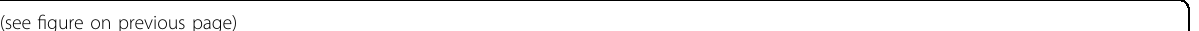
Fig. 4 NDUFA4L2 is not regulated by HIF-1 α in GBM and Apatinib effectively inhibits NDUFA4L2 expression and induces autophagy in GBM cells. A Immunoblot analysis of HIF-1 α and NDUFA4L2 protein levels in T98G, LN229, and GBM-XX cells cultured under normoxic or hypoxic conditions (1% O 2 for cell cultures). B Immunoblot analysis of HIF-1 α and NDUFA4L2 protein levels in LN229 cells cultured under normoxia or hypoxia for 24, 48, and 72 h. C Based on TCGA data, the correlation between the expression levels of HIF-1 α and NDUFA4L2 in patients with glioma was analyzed using the Pearson method. D Protein levels of HIF-1 α and NDUFA4L2 in T98G and GBM-XX cells cultured under normoxia with digoxin (100nM) or 2-ME (10 μ M) were determined by western blotting. E Protein levels of HIF-1 α and NDUFA4L2 in T98G and GBM-XX cells cultured under hypoxia (24 h) with digoxin or 2-ME were determined by western blotting. The images shown are representative of three experiments. F Immunoblot analysis of NDUFA4L2, LC3, p62, Beclin-1, and ATG7 protein levels in T98G, LN229, U373, and GBM-XX cells following treatment with apatinib (0, 5, 10, 20, and 40 μ M). G , H Apatinib-treated LN229 and GBM-XX cells that stably express the stubRFP-sensGFP-LC3 fusion protein were observed by fl uorescence microscopy. I Representative transmission electron microscopy images of T98G, LN229, and GBM-XX cells following treatment with apatinib (20 μ M). J Immuno fl uorescence images of apatinib-treated LN229 or GBM-XX cells showing DAPI (blue), cytochrome C (green), and NDUFA4L2 or LC3 (red) staining, as well as merged images of the three signals. The images shown are representative of three